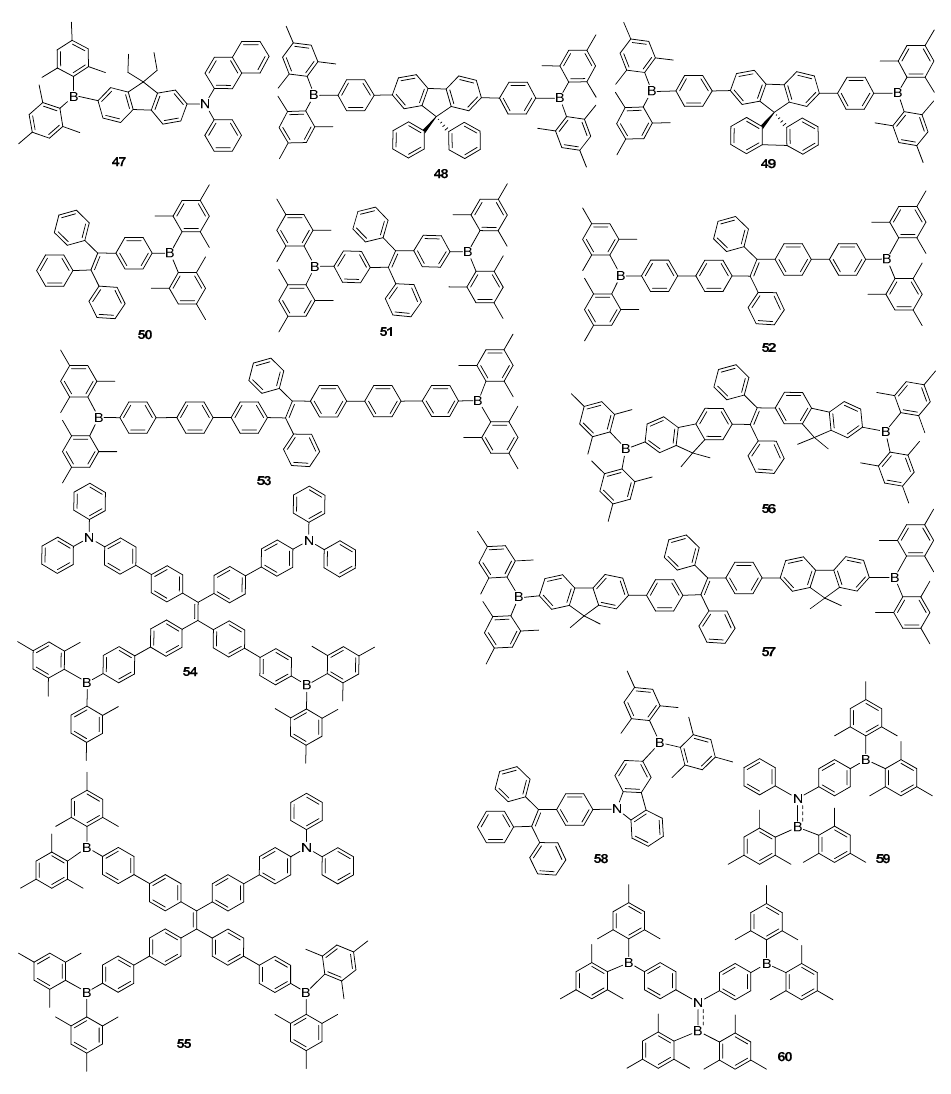
Figure 9. Triarylborane-based florescent materials 47 – 60 .